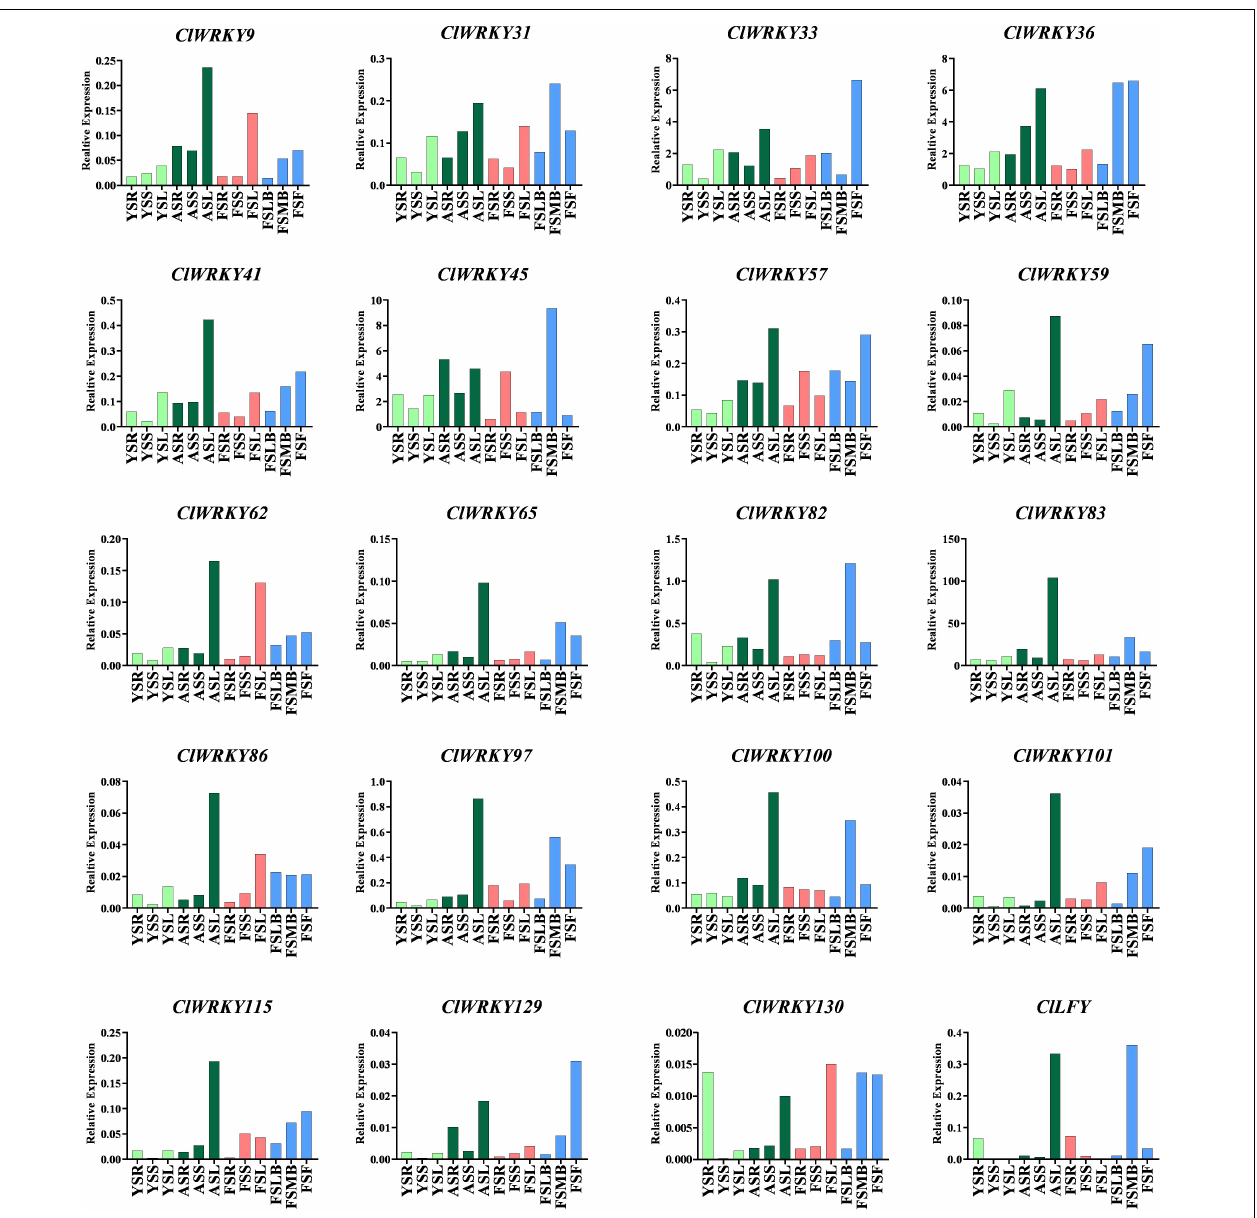
FIGURE 7 | Expression analysis of the selected ClWRKY genes in different tissues (capitulum, leaf, stem, and root) at different stages (young, adult, and flowering). Expression of 19 genes: 10 genes were selected due to the presence of CpG island, nine genes were selected based on their close association with important Arabidopsis genes found in the phylogenetic tree built between C. lavandulifolium and A. thaliana . Abbreviations of different growth stages and tissues are as follows: YSR, young stage root; YSS, young stage stem; YSL, young stage leaf; ASR, adult stage root; ASS, adult stage stem; ASL, adult stage leaf; FSR, flowering stage root; FSS, flowering stage stem; FSL, flowering stage leaf; FSLB, Flowering stage little buds; FSMB, Flowering stage buds; FSF, Flowering stage first